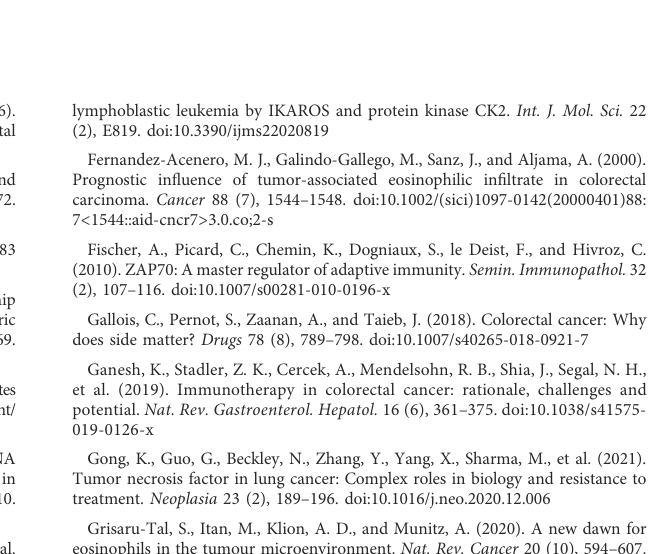
SUPPLEMENTARY TABLE S3 The correlations between lncRNA signatures and 458 differentially expressed immune